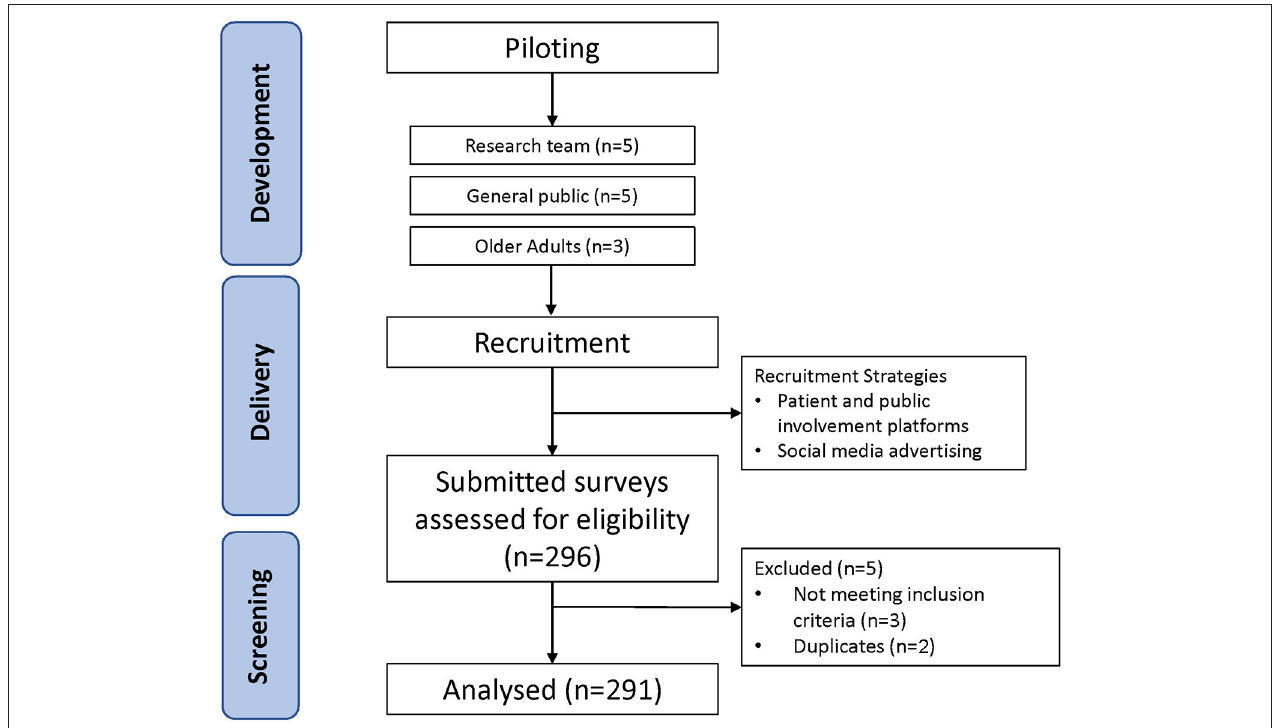
FIGURE 1 | Schematic of